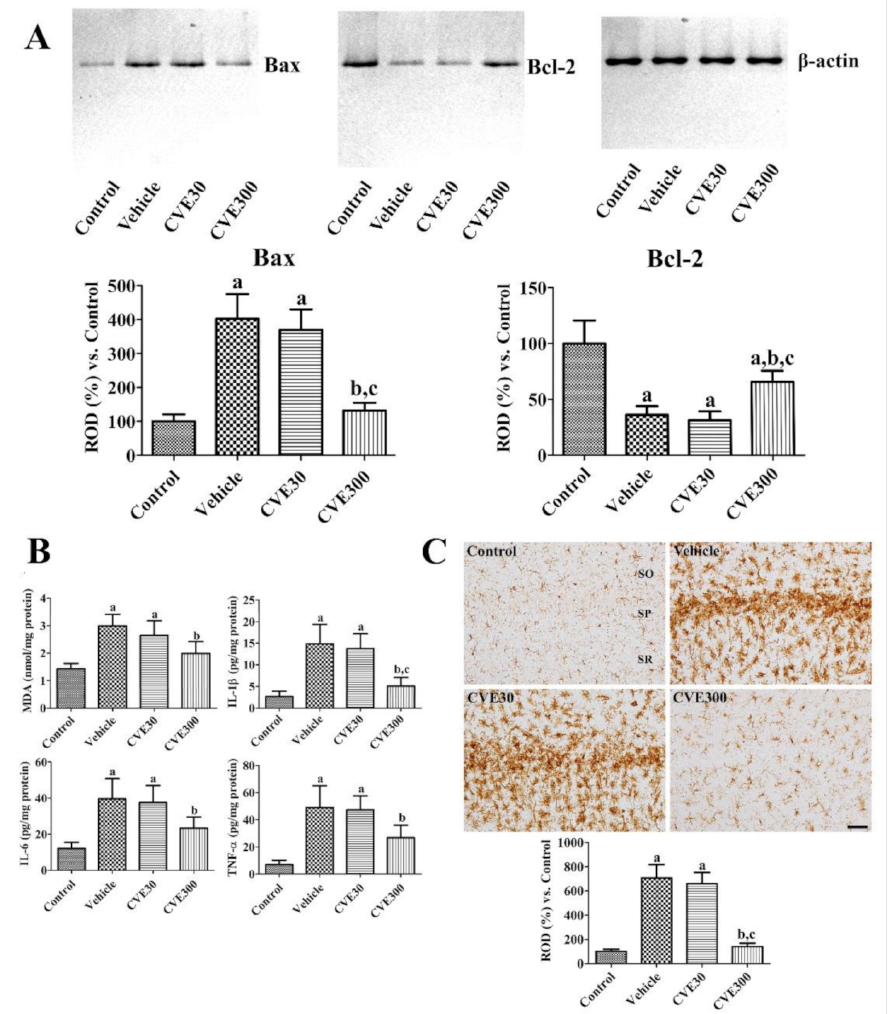
Figure 4. Cissus verticillata extract (CVE) ameliorates ischemia-induced apoptosis/anti-apoptosis, lipid peroxidation, pro-inflammatory cytokine releases, and microglial activation. ( A ) Three days after ischemia, apoptosis and anti-apoptosis were analyzed in the hippocampus using western blot for Bax and Bcl-2. ( B ) Six hours after ischemia, lipid peroxidation and pro-inflammatory cytokines were analyzed based on ELISA assay for MDA, IL-1 β , IL-6, and TNF- α in the gerbil hippocampus of control, vehicle, CVE30, and CVE300 groups (n = 5 per group). ( C ) Four days after ischemia, the hippocampi were immunostained with Iba-1 antibody to detect microglia in the hippocampal CA1 region. SO, stratum oriens; SP, stratum pyramidale; SR, stratum radiatum. Scale bar = 50 µ m. Optical density was analyzed and relative optical density (ROD) was represented as percentile values of control group ( n = 5 per group). ( A – C ) Data are presented as mean value ± standard deviation and were analyzed using one-way ANOVA followed by Bonferroni’s post hoc test ( a p < 0.05, significantly different from the control group; b p < 0.05, significantly different from the vehicle group; c p < 0.05, significantly different from the CVE30